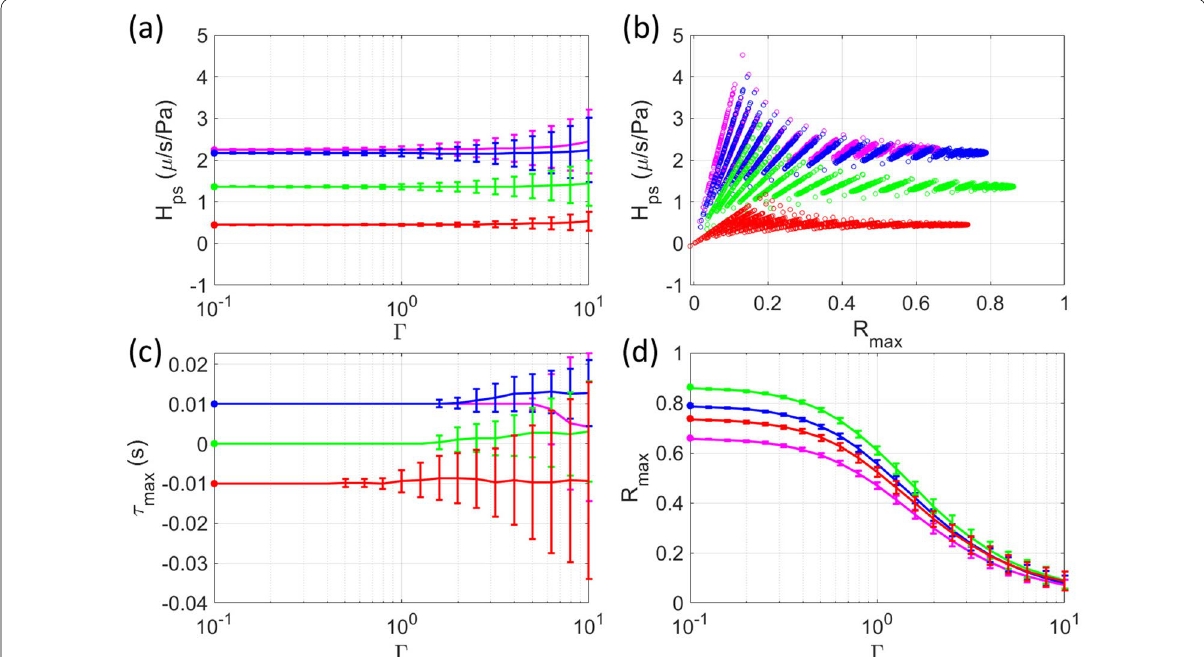
Fig. 4 Effect of background seismic signals, v s , in the seismic data, d v , on the estimation of H ps . The colors indicate the frequency bands: 1–3.5 Hz (red), 3.5–7 Hz (green), 7–12 Hz (blue), and 12–18 Hz (purple). One-hundred random functions are bandpass filtered and used as v s . The horizontal axes in a , c , and d are Ŵ , the square-root of power ratio of v s to the original d v that is approximated as v a . It is noted that the actual power ratio E ( v s )/ E ( v a ) is larger than Ŵ 2 E ( v s )/ E ( d v ) as d v itself contains a significant power of background signals. The lines and error bars show the means = and the standard deviations of H ps ( a ), the maximum correlation coefficient, R max ( d ), and the time delay, τ max , that gives R max ( c ) for the hundred random functions. The closed circles on the vertical axies are the values without v s . The relation between the individual R max and H ps for all the cases are shown with circles in